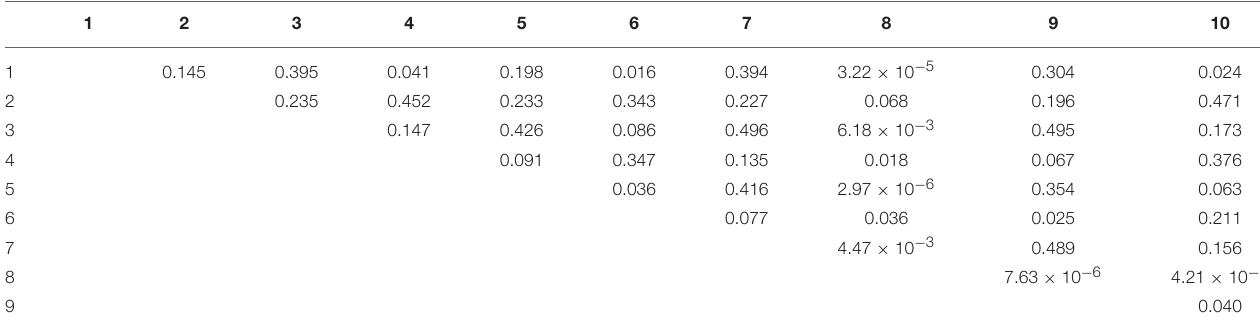
TABLE 3 | Table of p -Values for Unpaired Student’s t -Tests of RT-qPCR